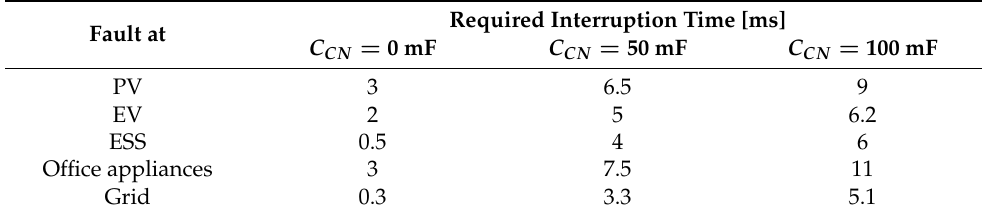
Table 3. Required interruption time before the grid’s current exceeds 400 A.